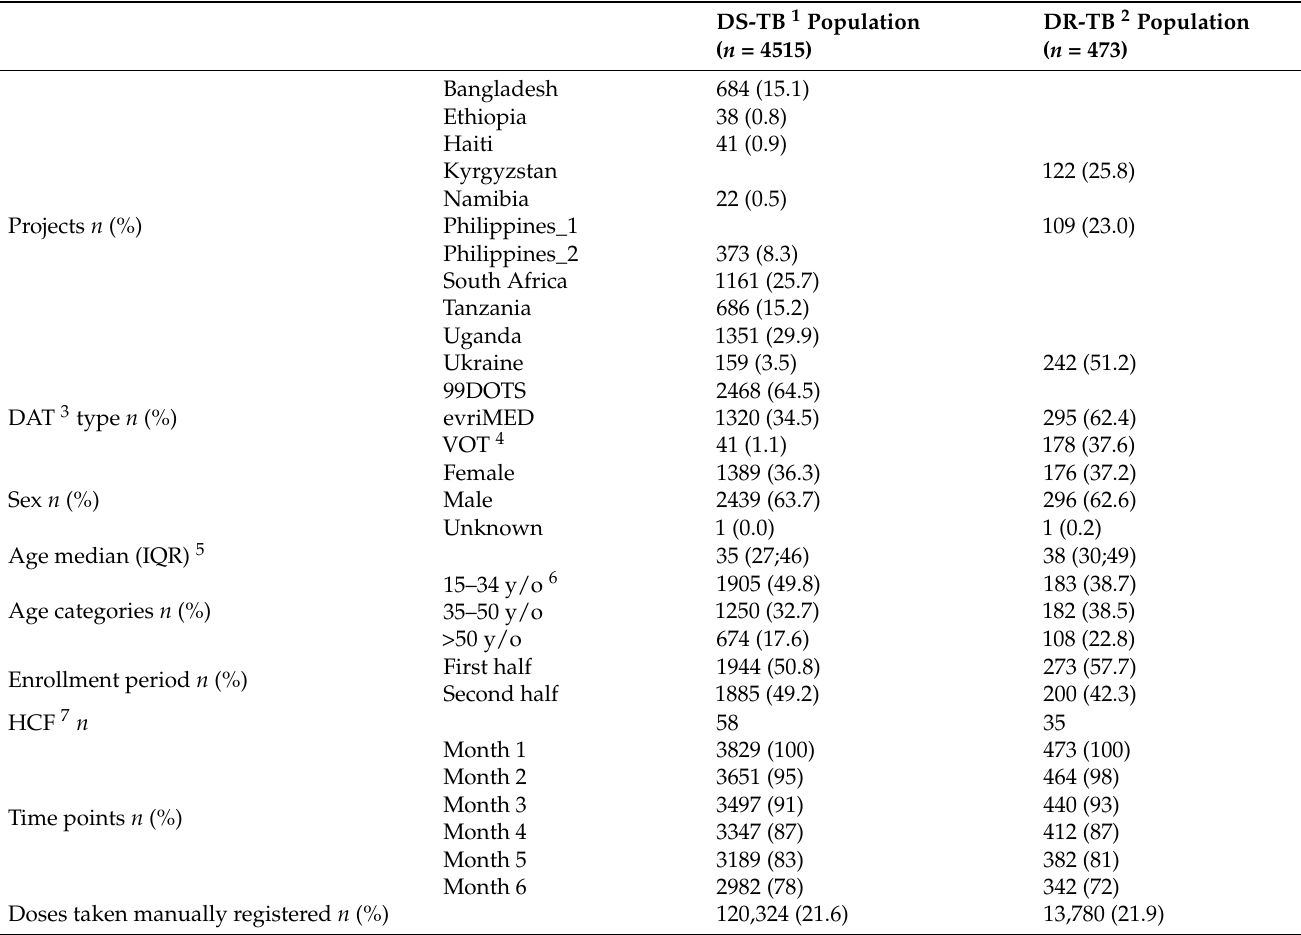
Table 2. Overview of study population, disaggregated by type of TB